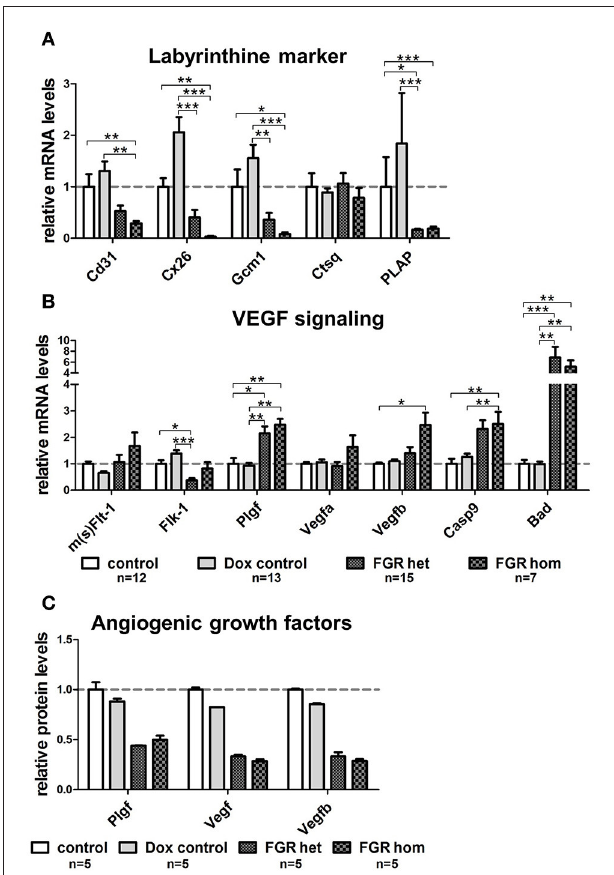
FIGURE 7 | Gene expression analysis of important placental labyrinthine markers and Vegf signaling molecules in the hsFLT1/rtTA mouse model. Quantitative reverse transcription polymerase chain reaction (qRT-PCR) of marker genes in placentas of each group: fetal growth restriction homozygous (FGR hom; n = 7), FGR heterozygous (het; n = 15), control ( n = 12), and doxycycline (Dox) control ( n = 13). (A) The mRNA level of fetal endothelial cell marker Cd31 was lower in placentas expressing human soluble fms-like tyrosine kinase 1 (hsFLT1) (FGR hom; FGR het) than in control placentas (control and Dox control). In addition, the expression of syncytiotrophoblast markers, such as gap junction protein connexin 26 ( Cx26 ) and differentiation-promoting transcription factor glial cell missing one ( Gcm1 ), is lower in hsFLT1–expressing placentas (FGR hom more pronounced than FGR het) than in control placentas (control and Dox control). The expression of maternal sinusoidal trophoblast giant cell markers, such as placental alkaline phosphatase ( PLAP ), was also lower in hsFLT1–expressing placentas than in control placentas, whereas cathepsin Q ( Ctsq ) expression seemed to be unaffected by hsFLT1 expression in all groups. (B) Murine mRNA levels of sFlt-1 and Flt-1 ( m(s)Flt-1 ) exhibited no clear up- or downregulation between groups (no discrimination between murine sFlt-1 and murine Flt-1 possible at the mRNA level), whereas the expression of murine fetal liver kinase 1 ( Flk-1 ) was lower in FGR hom and FGR het placentas than in control placentas (control and Dox control). Growth factors, such as placental growth factor ( Plgf ; mainly binding to sFlt-1 and Flt-1), vascular endothelial growth factor A ( Vefga ; mainly binding to sFlt-1, Flt-1, and Flk-1), and Vegfb (mainly binding to sFlt-1 and Flt-1), are upregulated at the time of hsFLT1 expression (FGR hom and FGR het), a finding correlating with increasing levels of hsFLT1. Nevertheless, the proapoptotic markers caspase9 ( Casp9 ) and Bcl-2–associated death promoter ( Bad ) downstream of Flk-1 are more